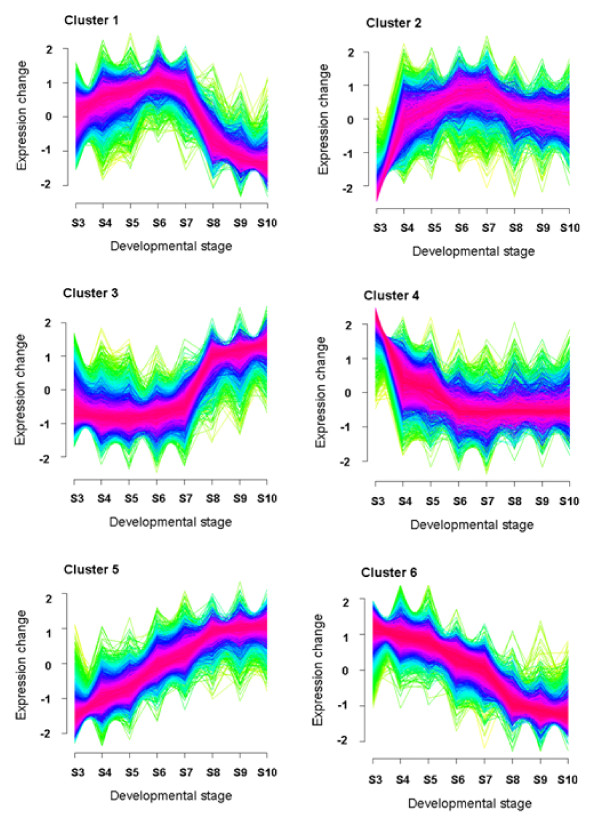
Fuzzy clustering of the expression data along seed development series. The six clusters showing the expression patterns during Arabidopsis seed development. The gene expression values were standardized to have a mean value of zero and a standard deviation of one for each gene profile. The transformed expressions were then clustered using the fuzzy c-means (FCM) clustering algorithm implemented in the Bioconductor Mfuzz package [89]. Based on preliminary analysis, we found six clusters can well represent different expression patterns inherent in the dataset, and another FCM parameter m = 1.75. A membership value in the range of 0-1 was assigned in clustering and the cluster cores consisting of genes with membership value > = 0.90 were coloured pink.